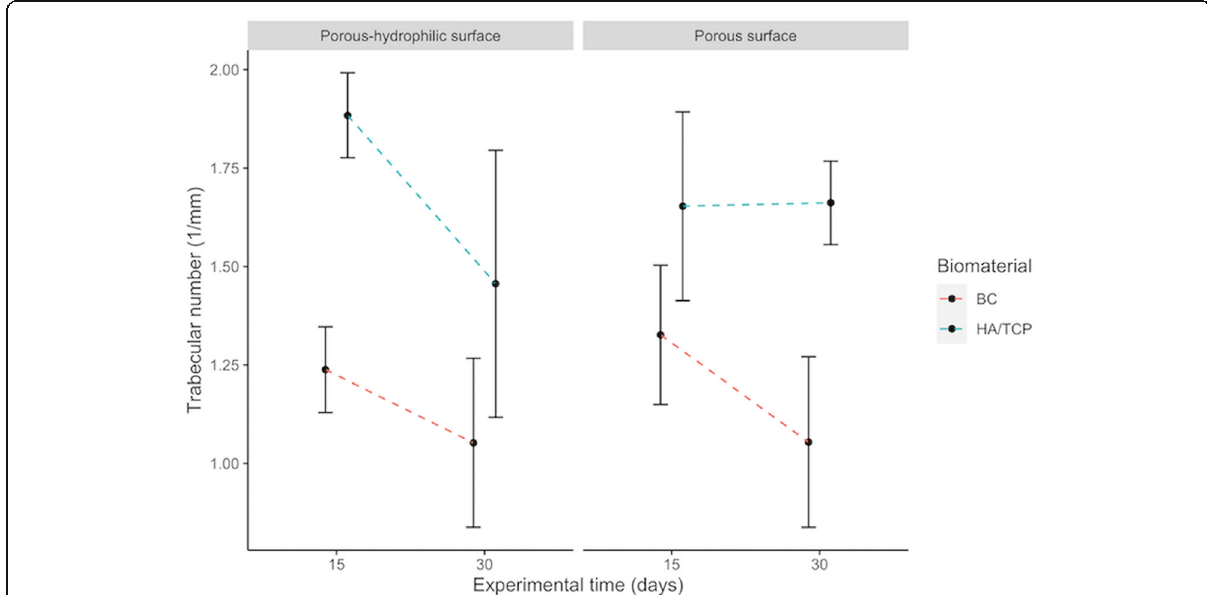
Fig. 2 Interactions among implant surfaces, bone substitute material or blood clot and experimental period on trabecular number. Error bars represent the standard deviation around the means